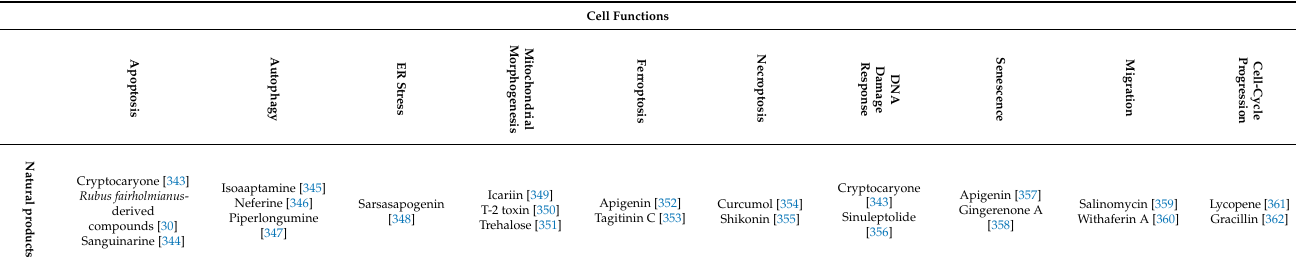
Table 5. Oxidative Stress-modulating natural products that modulate cell